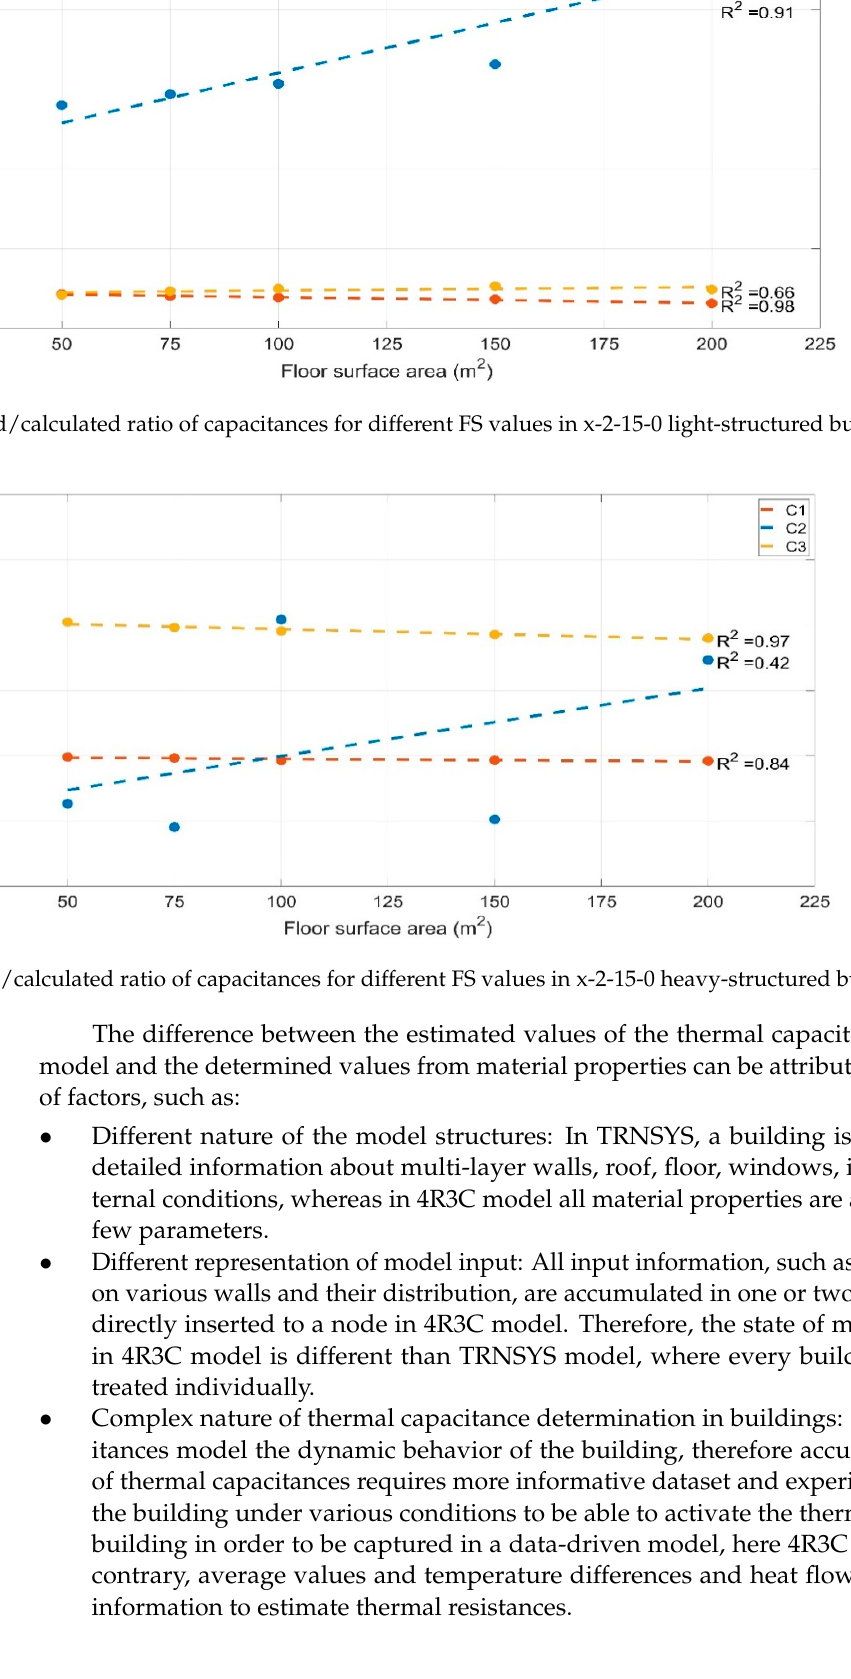
Figure 9. Estimated/calculated ratio of resistances for different floor surface areas in x-2-15-0 heavy-structured buildings.